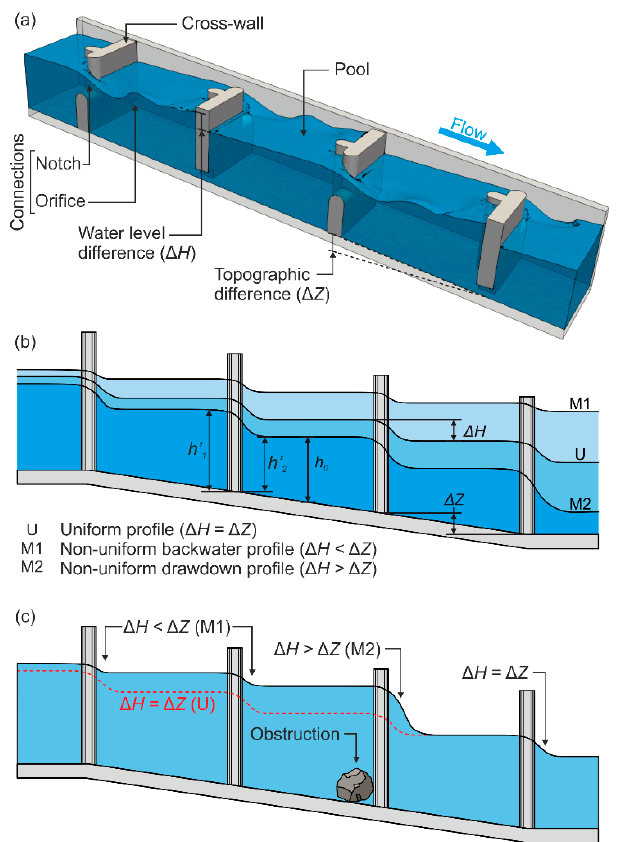
Figure 1. ( a ) A 3D sketch of a submerged notch and orifice stepped fishway. ( b ) Different scenarios in a fishway according to the natural variability of boundary conditions [15]. ( c ) Example of a